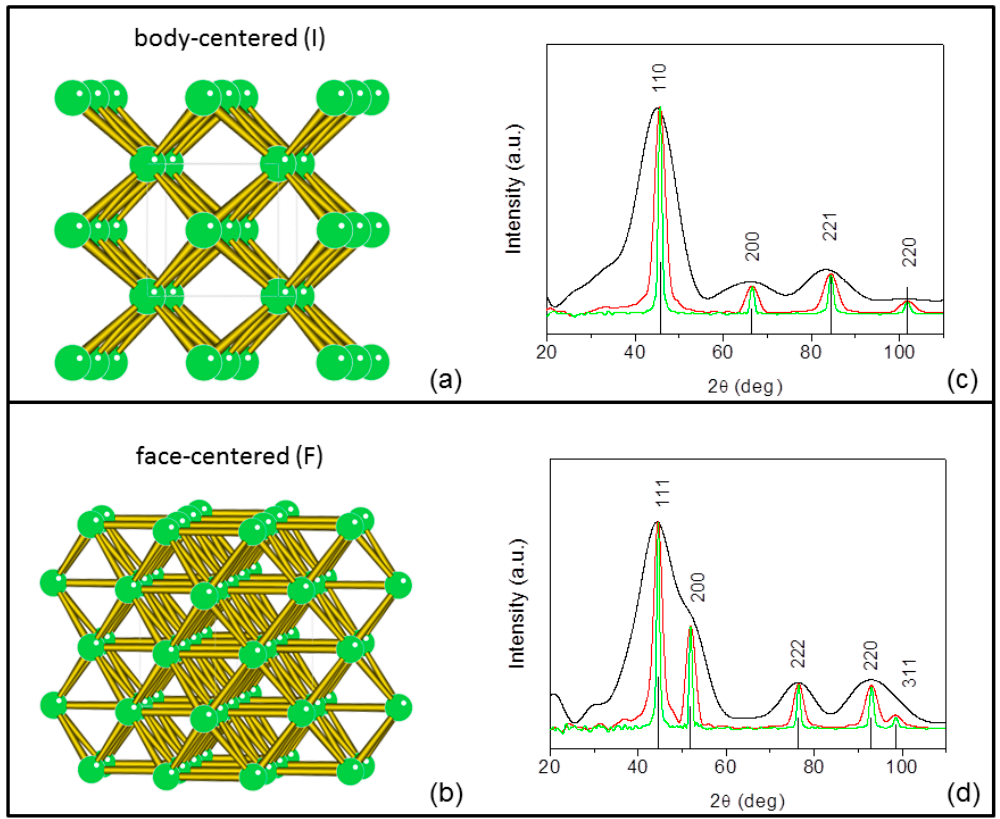
Figure 3. ( a ) Body centered cubic nickel lattice (ICSD database code 183264, i.e., a = b = c = 2.81 Å, α = β = γ = 90° and space group = I m − 3 m); ( b ) face centered cubic nickel lattice (ICSD database code 181716, i.e., a = b = c = 3.227 Å, α = β = γ = 90° and space group = F m − 3 m); ( c ) simulated diffraction patterns for the ICSD 183264 structure; ( d ) simulated diffraction patterns for the ICSD 181716 stucture. The simulated profiles are computed for a crystalline box containing 3 × 3 × 3 (black profile), 10 × 10 × 10 (red profile) and 30 × 30 × 30 (green profile) unit cells. Wavelength used for calculation: λ = 1.540562 Å.